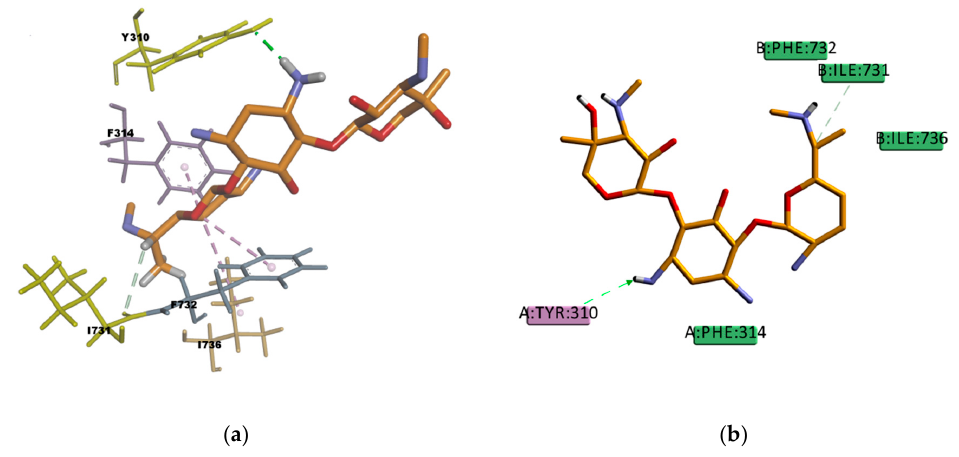
Figure 20. Gentamicin (GEN) top-ranked pose obtained with CDOCKER algorithm. ( a ) 3D view of GEN interactions in the binding pocket. Green dotted line represents a conventional hydrogen bond interaction, light-green dotted line represents a carbon hydrogen bond interaction, and light-rose dotted lines represent hydrophobic interactions. Residues Y310 and I731 involved in hydrogen bond interactions are highlighted in yellow; ( b ) 2D interaction diagram of GEN with h P-gp interacting residues. The green dotted line represents a conventional hydrogen bond interaction with residue Y310, and the light-green dotted line represents a carbon hydrogen bond interaction with residue